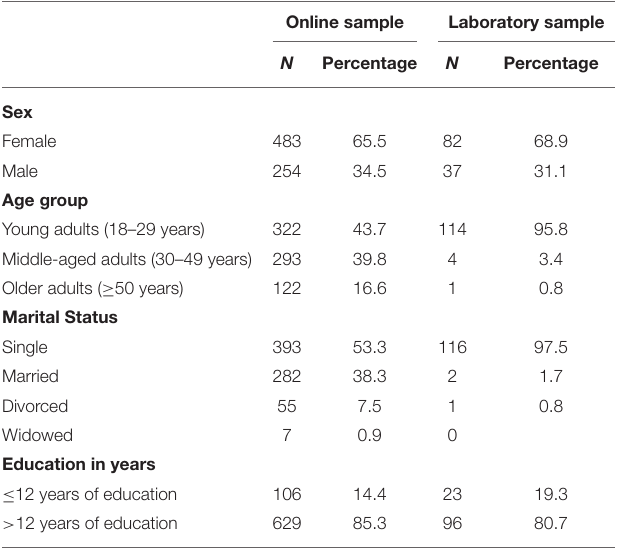
TABLE 1 | Characterization of the sample regarding sex, age group, marital status, and years of education. Online